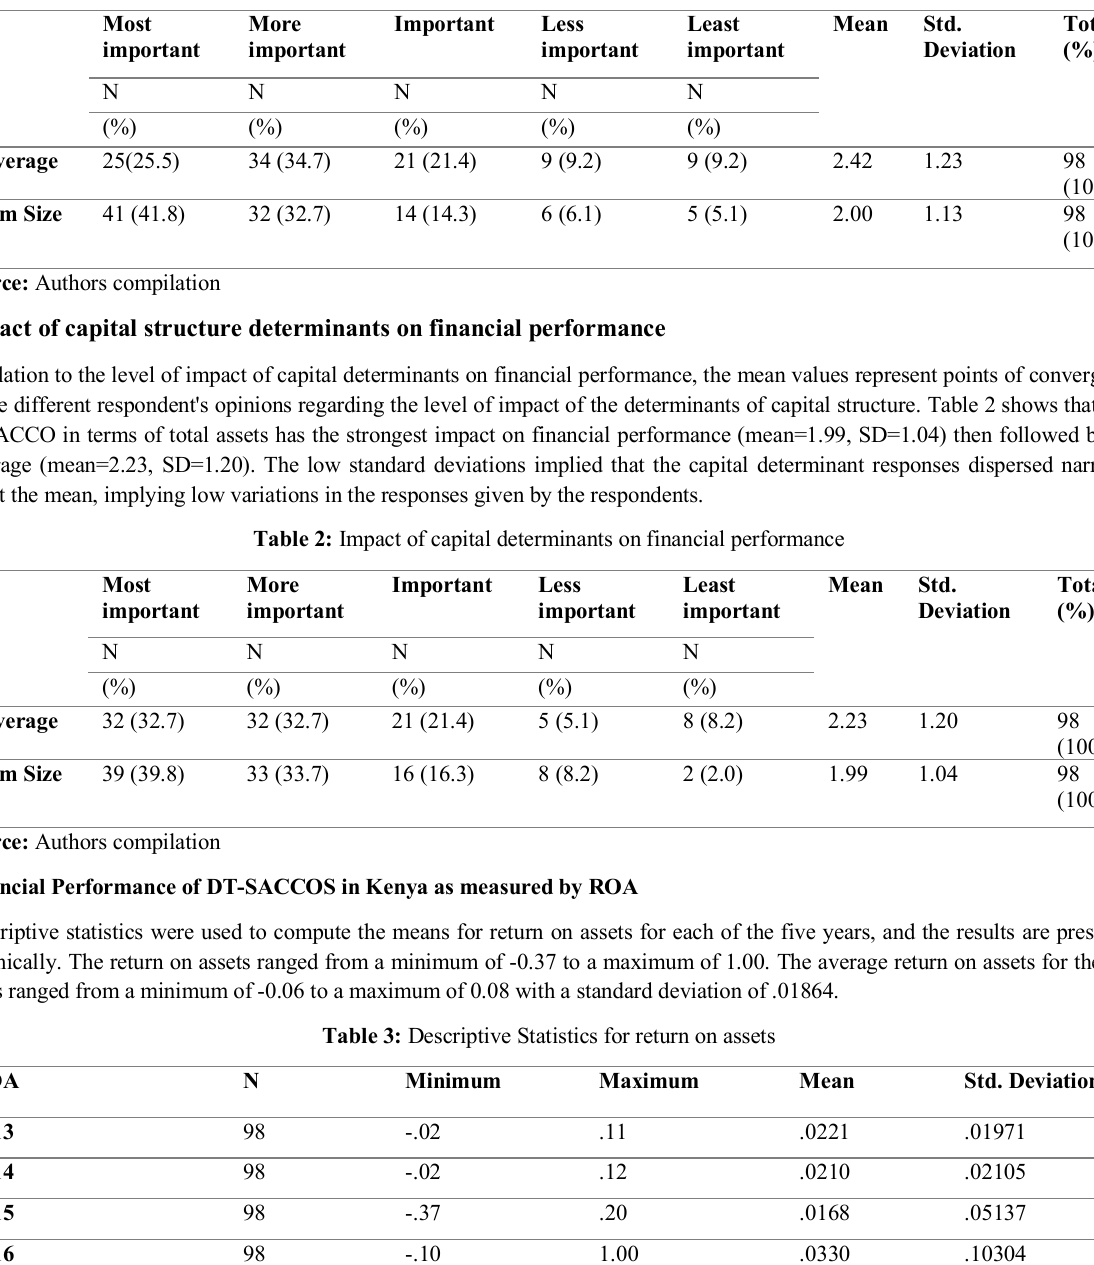
Table 1: Rating on determinants of capital structure